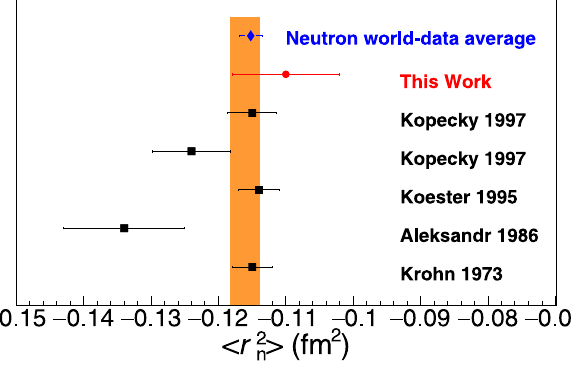
i measurement Fig. 4 The neutron mean square charge radius. The h r 2 n from this work (red circle), with the error bar corresponding to the total uncertainty at the 1 σ or 68% con fi dence level, and from references 3 – 6 i . The orange-band indicates (black box) included in the PDG analysis for h r 2 n i value. The new weighted average of the world data the PDG averaged h r 2 n i measurement reported in is also shown (blue diamond) when the new h r 2 n this work is included in the